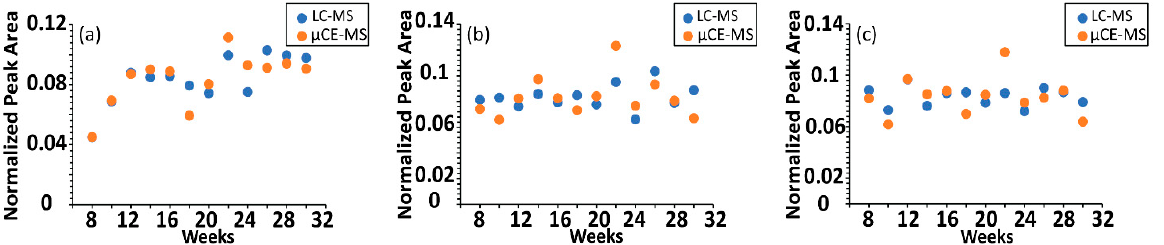
Figure 3. Comparison of time-resolved serum metabolomics data acquired with UHPLC-MS and µCE-HRMS platforms. Normalized peak abundance of ( a ) serine, ( b ) threonine, and ( c ) citrulline in a TKO control mouse. UHPLC-MS abundances are shown in blue and µCE-HRMS data are shown in orange. For visualization purposes, data were normalized to the sum of the peak areas for all time points.